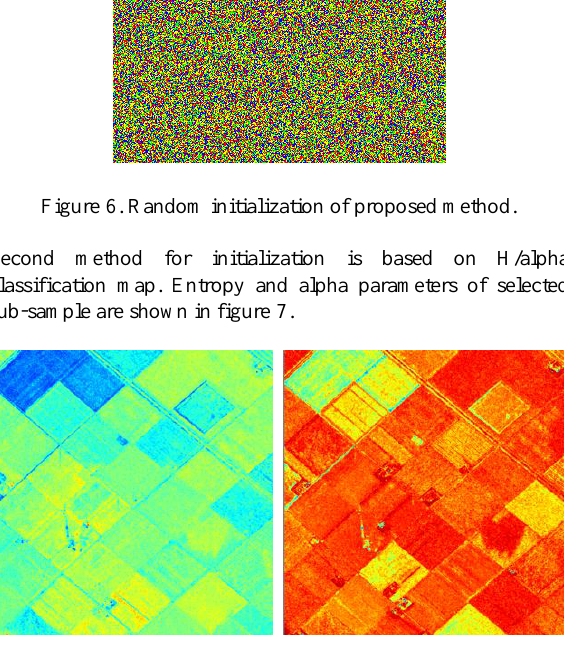
Figure 7. alpha (a) and entropy (b) parameters for selected sub- set of PolSAR data.